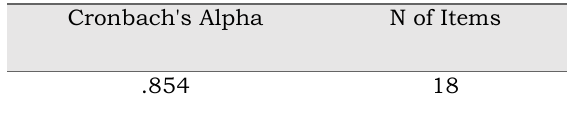
Table 3. Reliability statistics of the students’